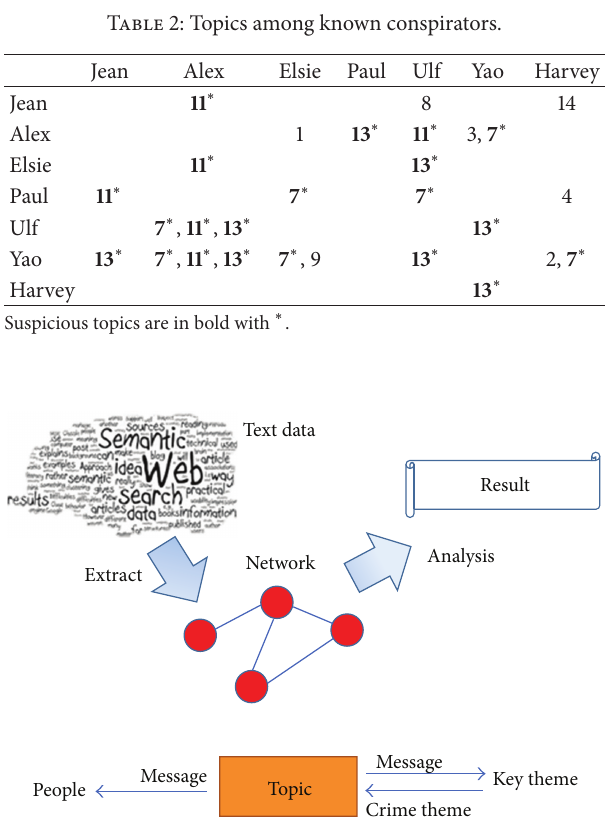
Figure 1: Semantic network analysis